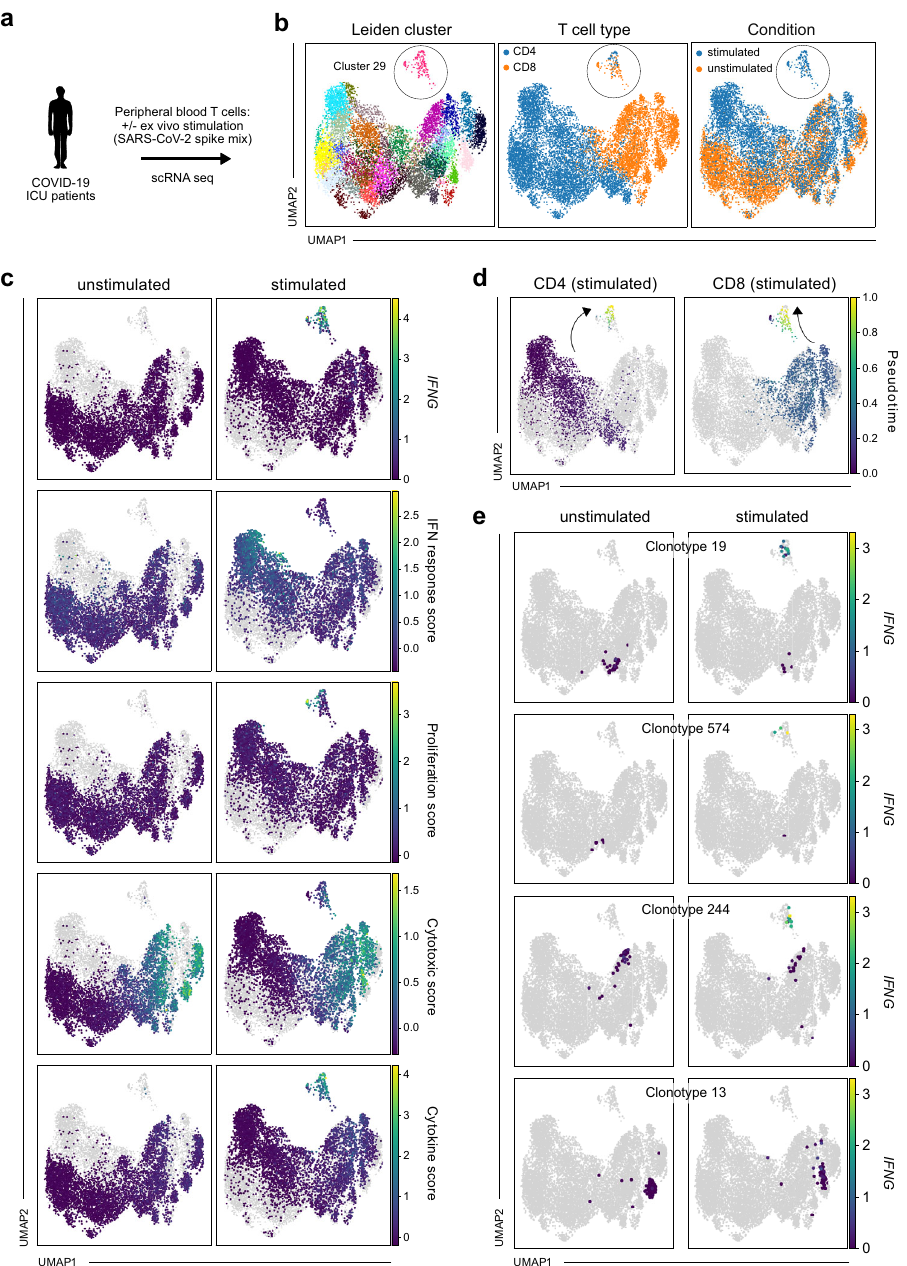
Fig. 1 Single-cell RNA sequencing allows detection of transcriptional shifts induced by antigen-speci fi c stimulation in TCR-barcoded clonotypes. a Experimental setup; cells from tracheal aspirates and peripheral blood T cells ( fl ow cytometry-sorted for CD4 or CD8 positivity) of intensive care unit (ICU) patients with COVID-19 were pro fi led by single-cell RNA sequencing (scRNA seq). Before scRNA seq, peripheral blood T cells were stimulated with SARS-CoV-2 spike protein – peptide mix or left untreated. b Uniform manifold approximation and projection (UMAP) of Leiden clusters (left panel), CD4 and CD8 T cells (middle panel), and stimulated and unstimulated T cells (right panel) ( n = 11,460 cells in total). c IFNG expression, IFN response score, proliferation score, cytotoxic score, and cytokine score (from top to bottom) in unstimulated (left panels; stimulated cells shown in gray) or stimulated (right panels; unstimulated cells shown in gray) T cells ( n = 11,460 cells in total). d Stimulated CD4 and CD8 T cells with highlighted pseudotime after de fi ning the endpoint of pseudotime at the tip of cluster 29 ( n = 11,460 cells in total). e IFNG expression in unstimulated or stimulated T cells for four representative clonotypes. For each clonotype, cells belonging to that clonotype are shown in an individual panel pair (cells from the unstimulated condition in left panels, cells from the stimulated condition in right panels), while cells not belonging to that clonotype are shown in gray ( n = 11,460 cells in total, 43 cells for CD4 clonotype 19, 8 for CD4 clonotype 574, 61 for CD8 clonotype 244, 165 for CD8 clonotype 13). Data are shown for patient